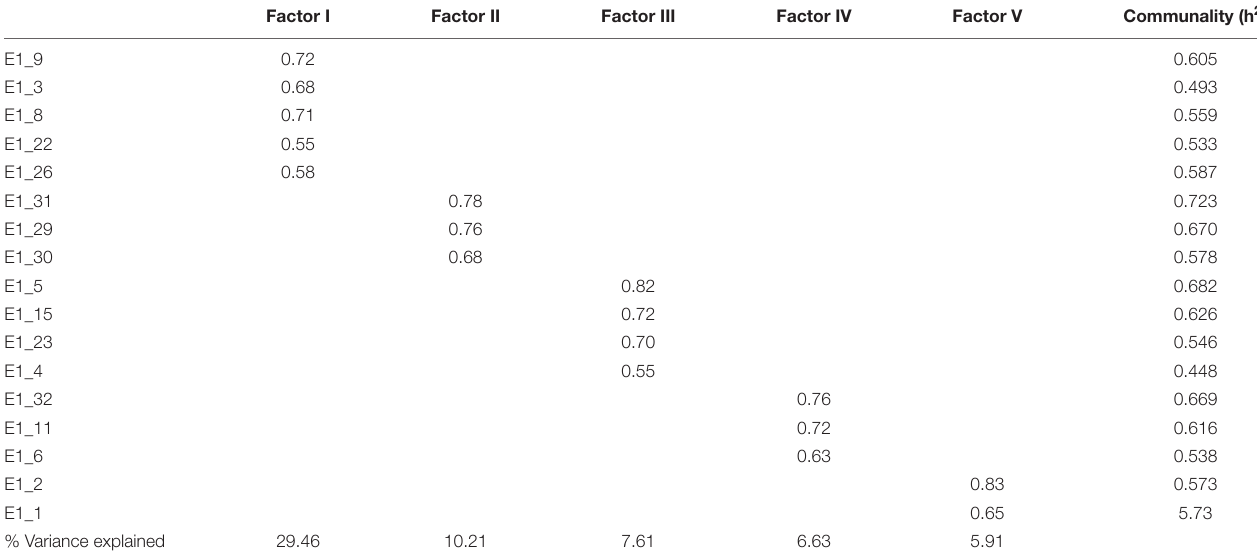
TABLE 2 | Exploratory factor